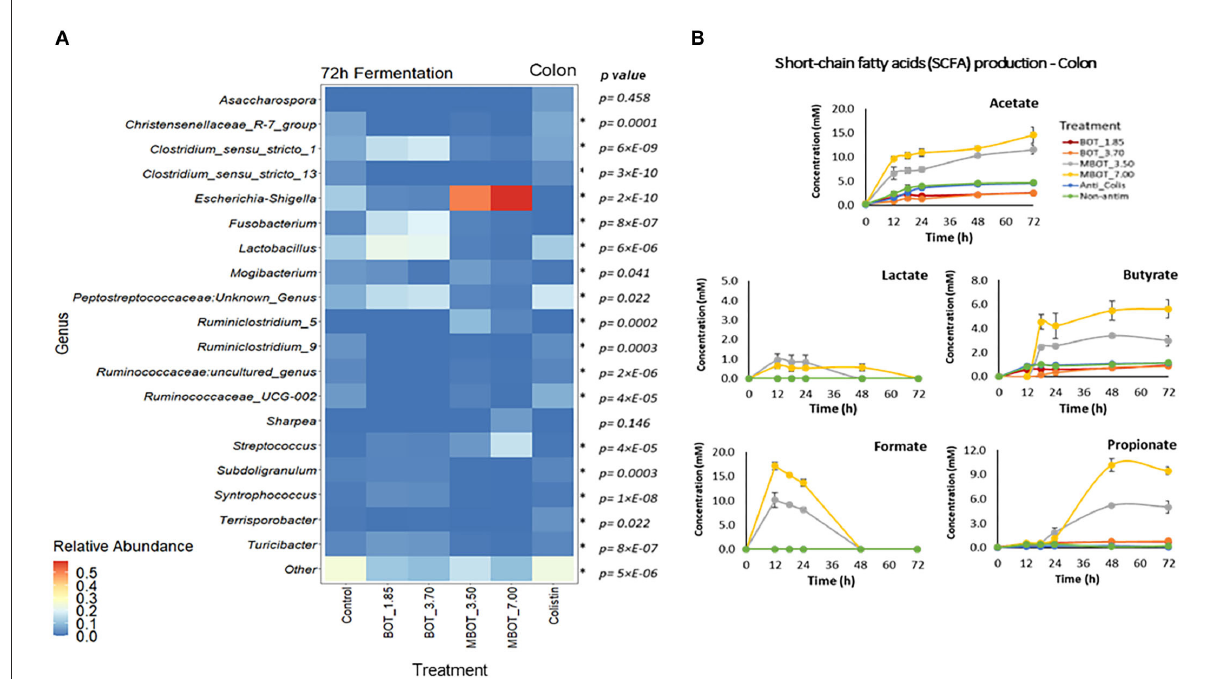
FIGURE5 Heat map of the relative abundance of the top-19 genera present in colon microbial fermentation (A) and short chain fatty acid (SCFA) production (B) as affected by unprotected BOT, microencapsulated BOT (MBOT), and colistin after 72h of fermentation. p -values were calculated by a one-way ANOVA model and asterisks (*) indicate significant differences ( p < 0.05). Vertical bars indicate the standard